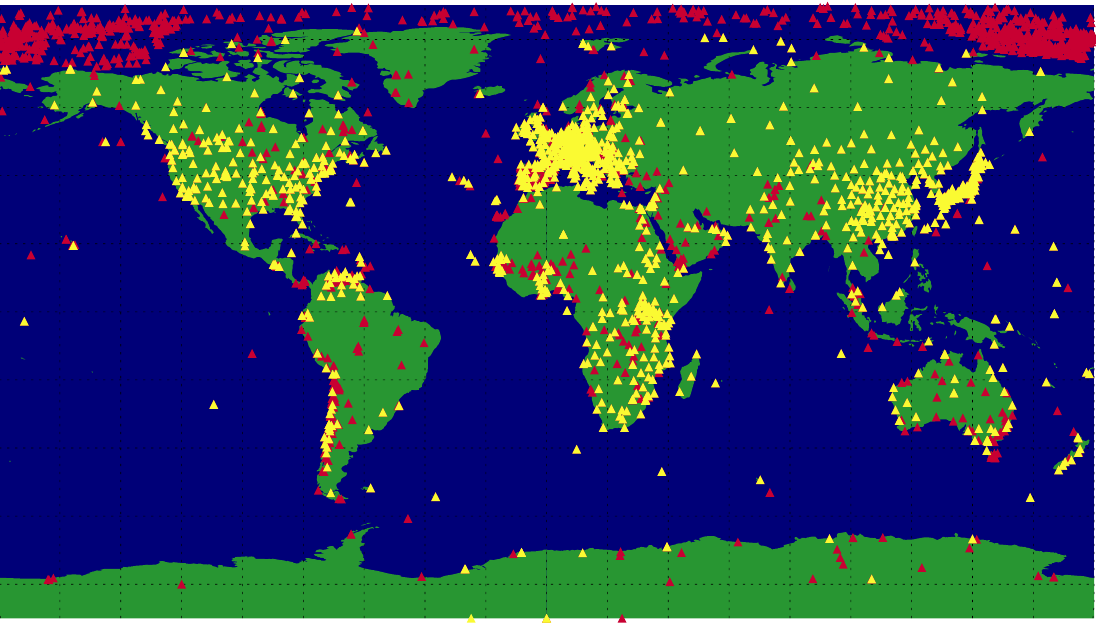
Figure 1. Distribution of the 2500 locations with observational data contained in GEBA. Red symbols indicate locations with at least one monthly entry in GEBA; yellow symbols signify locations with multiyear records (at least 3 years of data).